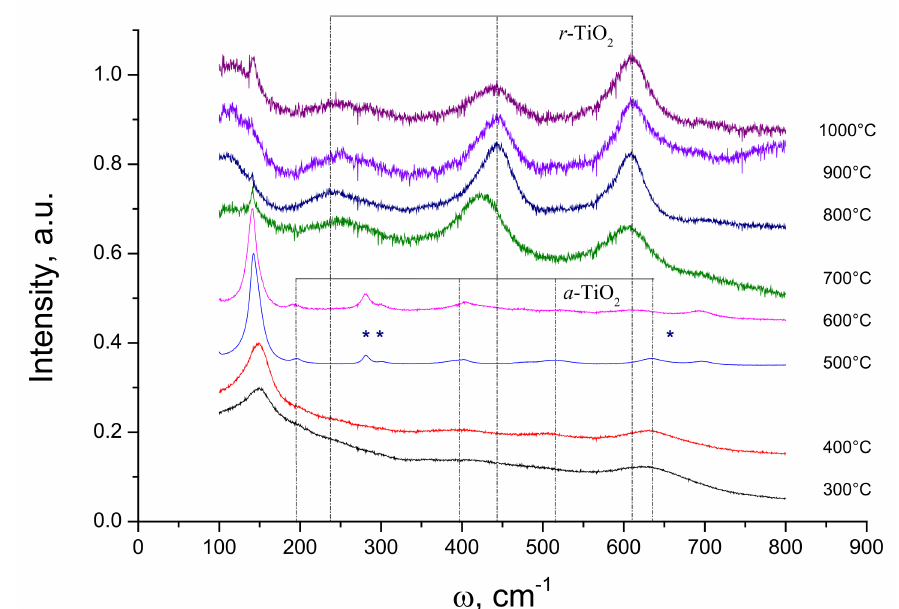
Figure 6. Raman spectra of V-TiO 2 samples with 20 mol% vanadium content heat treated at different temperatures for 4 h. Positions of anatase ( a ) and rutile ( r ) TiO 2 bands are indicated by vertical dashed lines. Stars indicate unassigned bands (see in